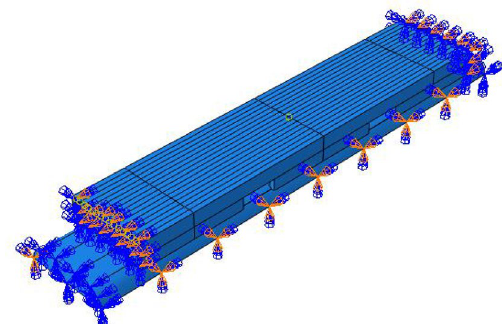
Figure 4 Boundary model of rail –abrasive belt—press grinding plate